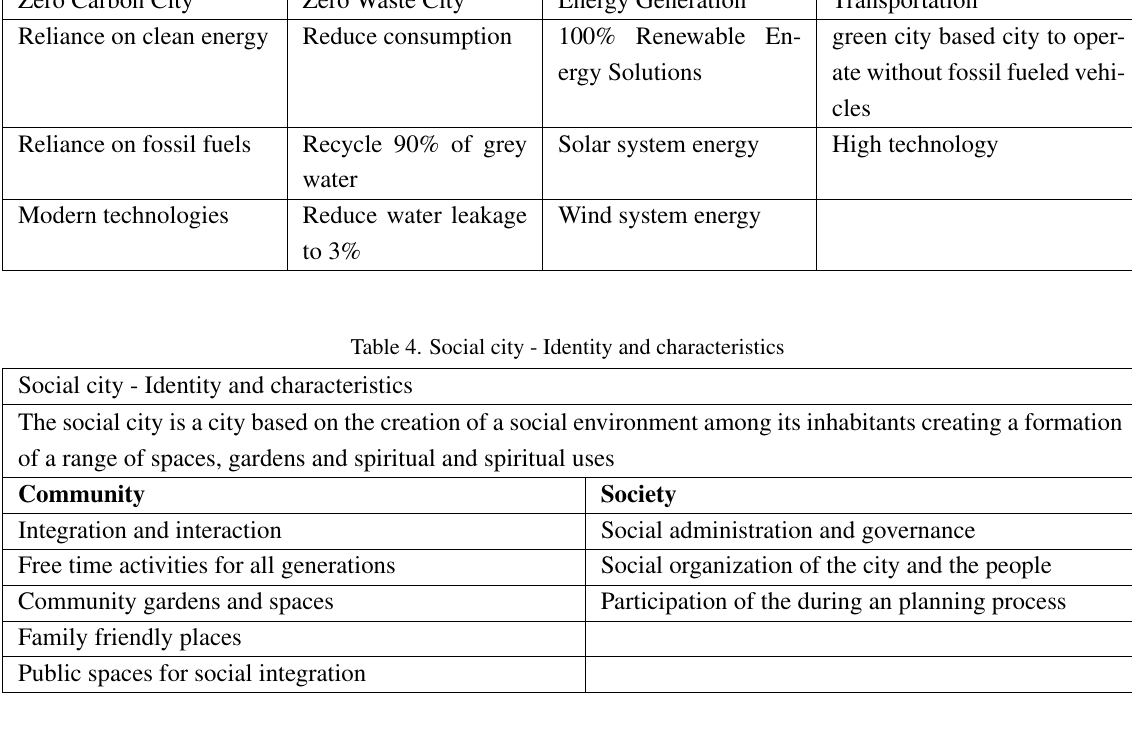
Table 5. Recreation city - Identity and characteristics